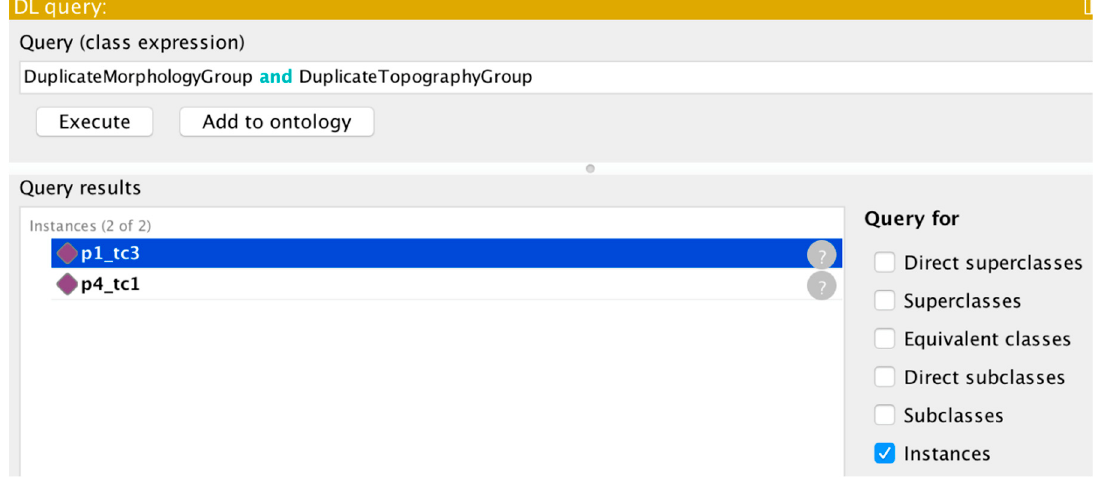
Figure 15. DL query for entities with both a duplicate topography and a duplicate morphology condition (one of the triggers for a multiple primary tumour).